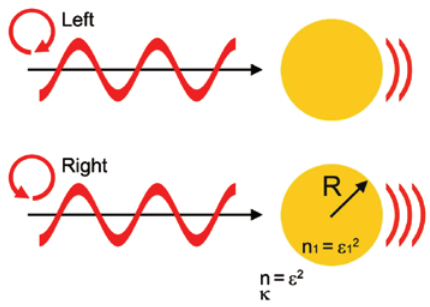
Figure 2: Example of chirally perturbed resonances in nanostructures embedded in the chiral medium. Left and right circularly polarized lights excite the plasmonic nanoparticle differently although the nanoparticle is achiral. Reprinted with permission from Ref. [35], copyright 2015, Nature Publishing